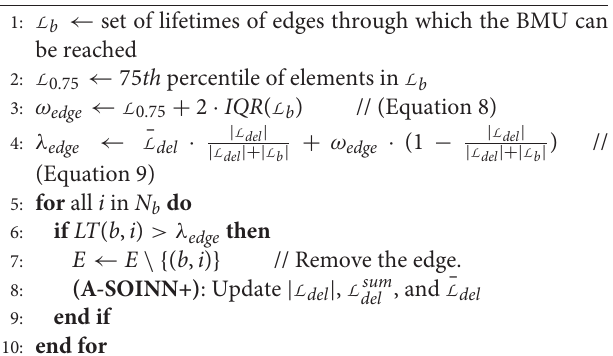
Algorithm 5 . (Associative) SOINN+ Edge deletion